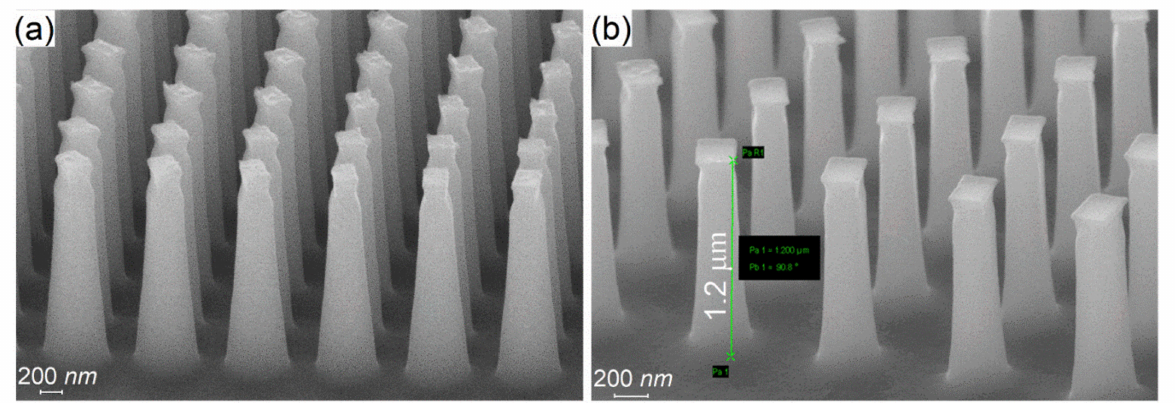
Figure 4. Patterned silicon after cryogenic etching process using ( a ) a deficient and ( b ) an optimal O 2